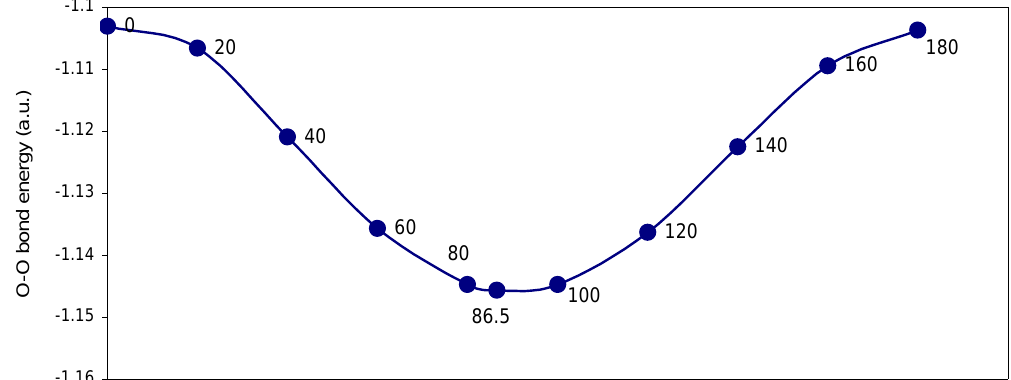
Figure 9. Plot of 'O-O' bond energy (a.u)as a function of torsional angles in fluorine